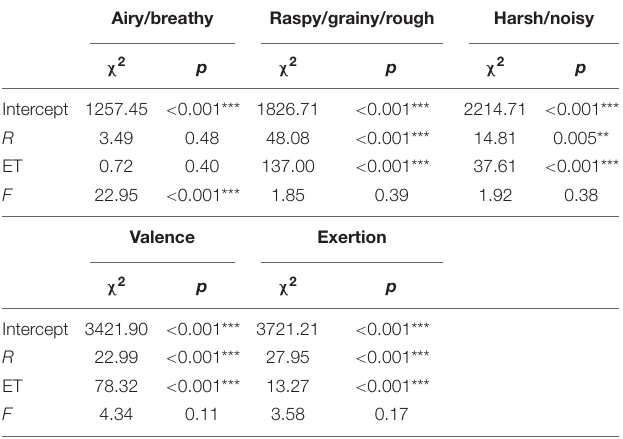
TABLE 2 | Effects of the factors register (R), extended technique (ET), and instrument family (F) on each semantic category, as well as on valence and